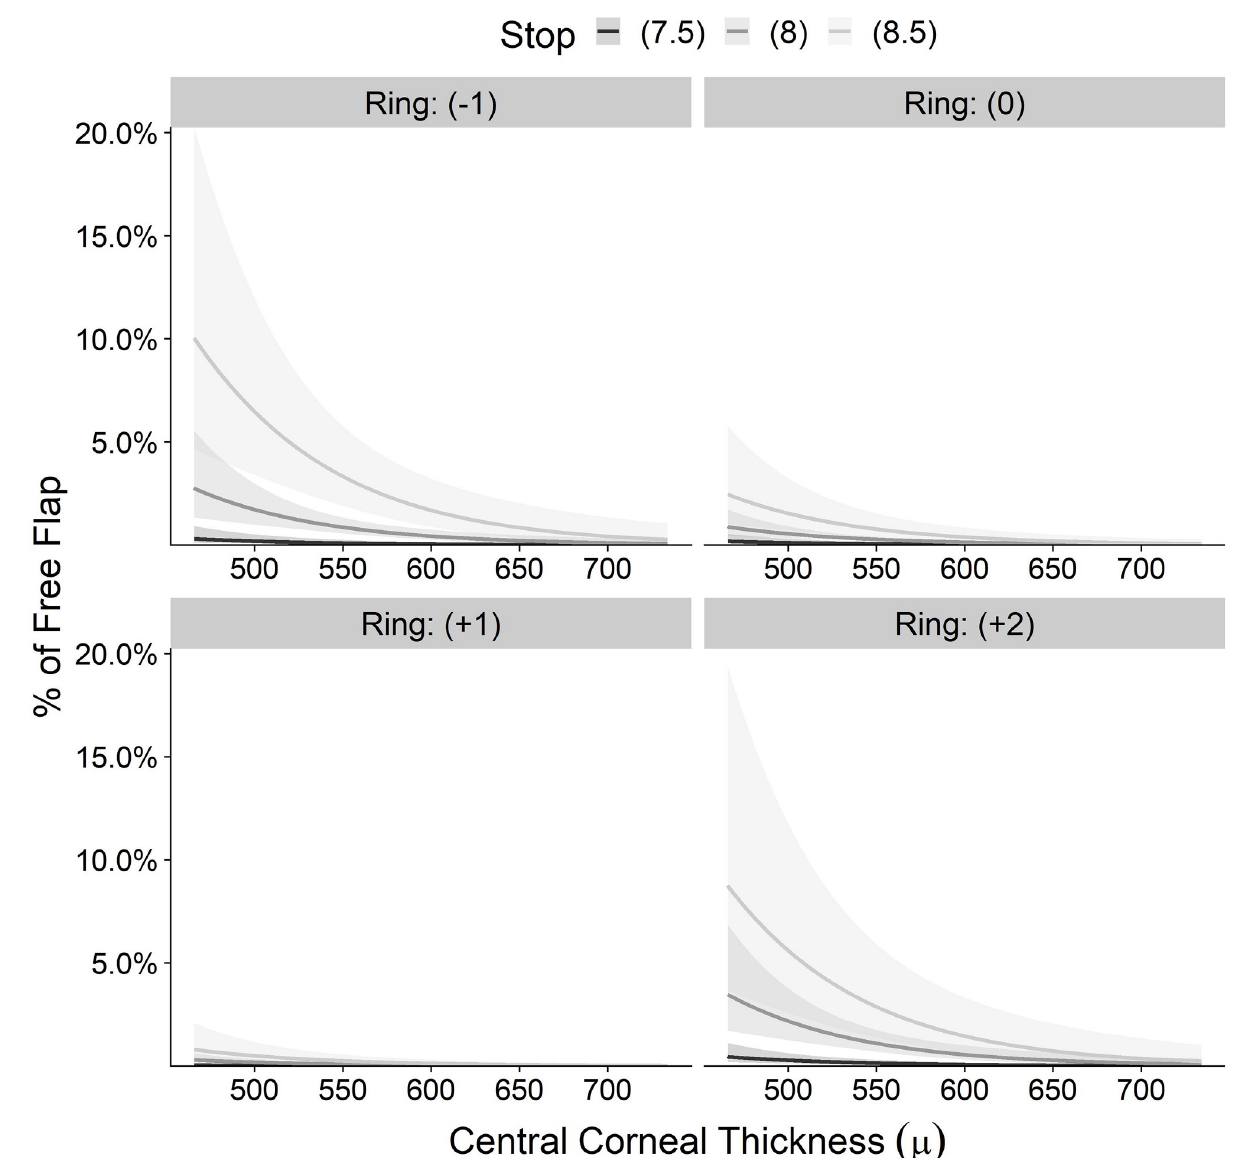
Fig 8. Predicted incidence of free flap by central corneal